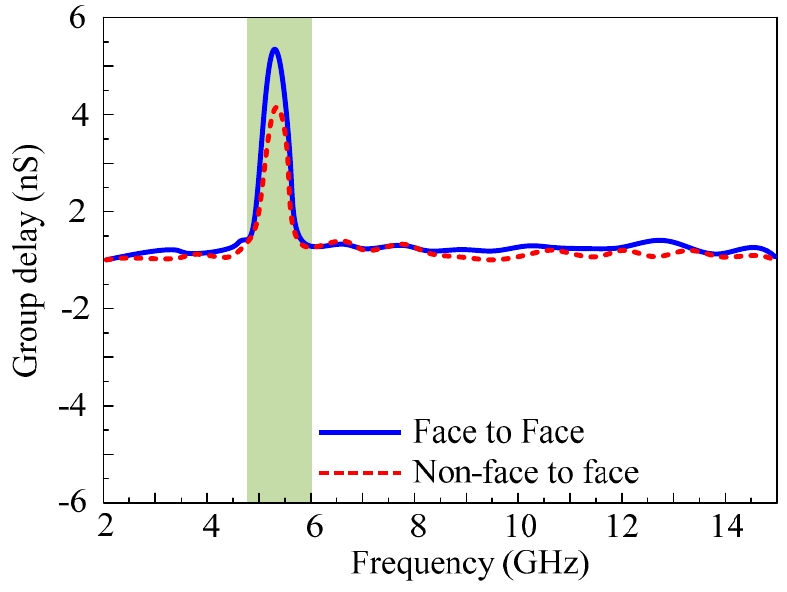
Figure 9. The group delay of the proposed notch band extended UWB antenna.